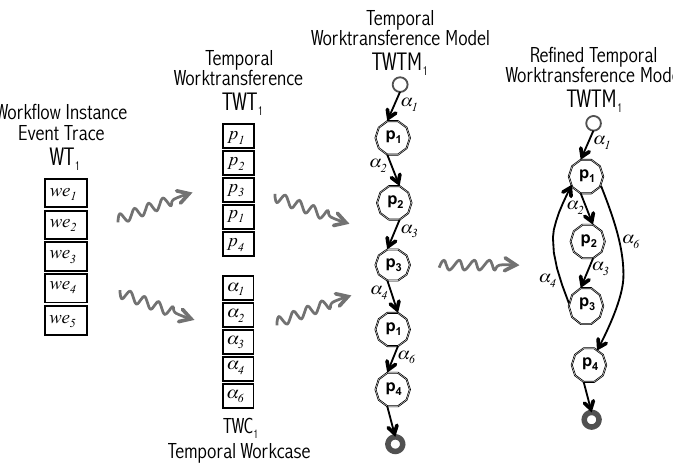
Figure 3. Conceptual steps in building a temporal work transference model from an event